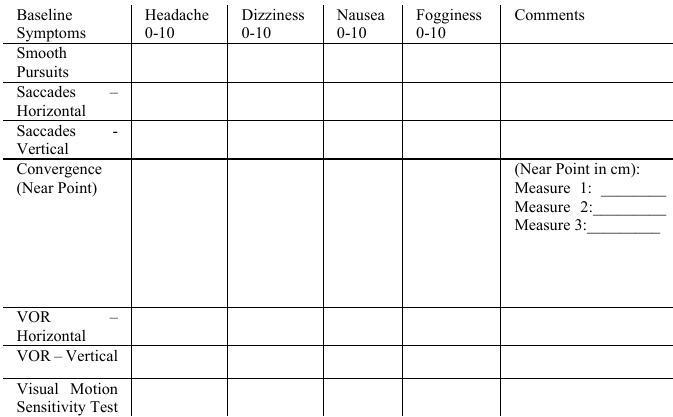
Table 1: Vestibular/Ocular Motor Screening (VOMS) tool, adapted from (Alberta, 2014) Baseline